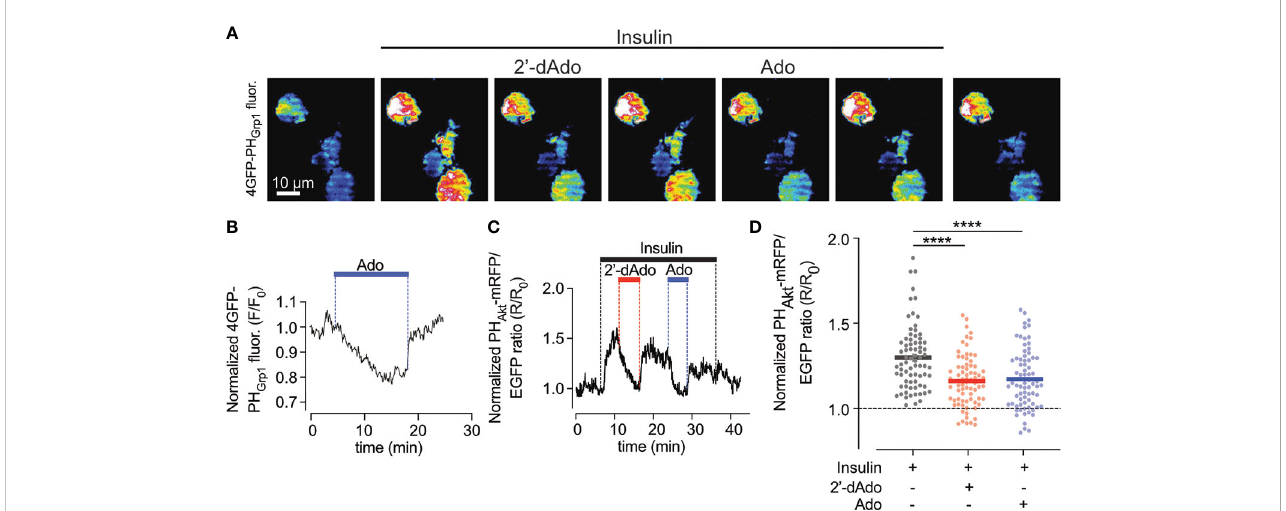
FIGURE 2 Adenosine and deoxyadenosine reduce plasma membrane PI(3,4,5)P 3 levels. (A) TIRF microscopy images of four EndoC- b 1 cells expressing GFP 4 -GRP1 PH following exposure to the indicated drugs. (B) TIRF microscopy recordings of GFP 4 -GRP1 PH fl uorescence from a EndoC-betaH1 cell exposed to 1mM adenosine (Ado). (C) TIRF microscopy recording of PH Akt -mRFP/EGFP ratio in a EndoC-betaH1 cell sequentially exposed to 100 nM insulin, 1mM of deoxyadenosine (2 ’ dAdo) and 1 mM adenosine (Ado). Note that the addition of insulin stimulated plasma membrane PI(3,4,5)P 3 production, which was supressed by both adenosine and deoxyadenosine. (D) Quanti fi cation of the relative GFP 4 -GRP1 PH /mCherry and PH Akt -mRFP/GFP ratio change at the plasma membrane of EndoC-betaH1 in response to 100 nM insulin or the combination of insulin and adenosine or deoxyadenosine. Quanti fi cations of the GFP 4 -GRP1 PH/ mCherry and PH Akt -mRFP/EGFP from EndoC-betaH1 cells are presented as means ± S.E.M. for the indicated number of cells. (n=75 cells per group; ****P < 0.001; paired, 2-tailed Student ’ s